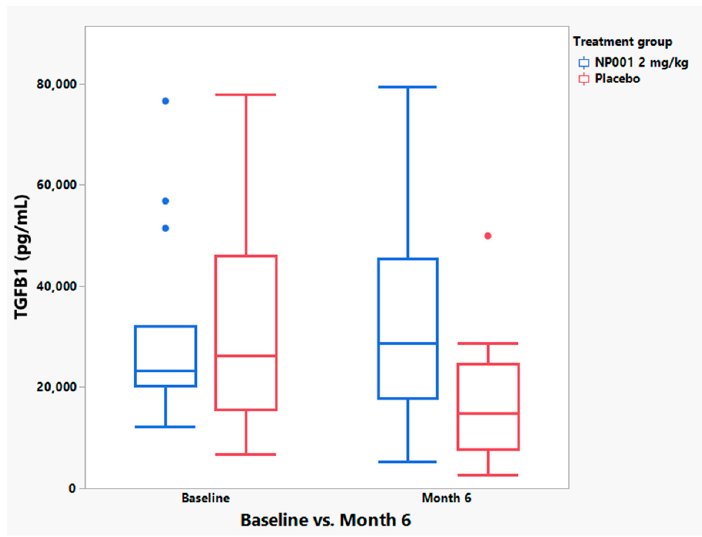
Figure 9. TGFB1 levels significantly increased over the 6-month trial in NP001 treatment compared to placebo controls in participants aged ≤ 65 years old with high plasma CRP at baseline. Box and Whisker plots depicting the distribution of baseline and end of study (month 6) plasma TGFB1 values for NP001-treated ( n = 15 patients, in blue) and placebo group ( n = 16 patients, in red) where the bottom of the box depicts the first quartile of the data, the solid line through the box represents the median, and the top of the box depicts the third quartile of the data. The ends of the “whiskers” depict the maximum and minimum values (Wilcoxon test, p = 0.89 for baseline and p = 0.02 for month